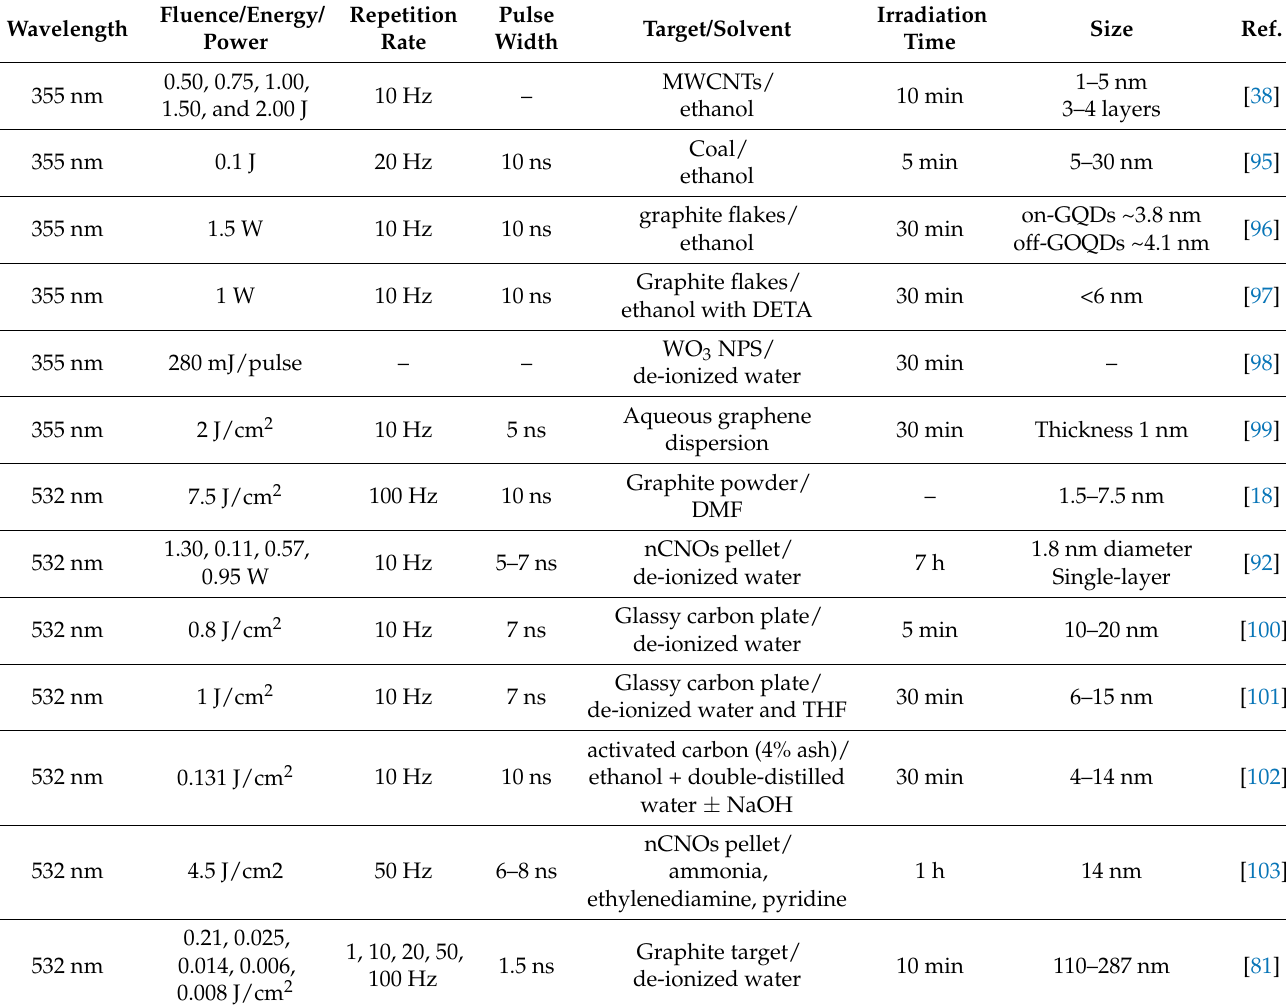
Table 3. Experimental conditions for the fabrication of GQDs and GOQDs via PLAL